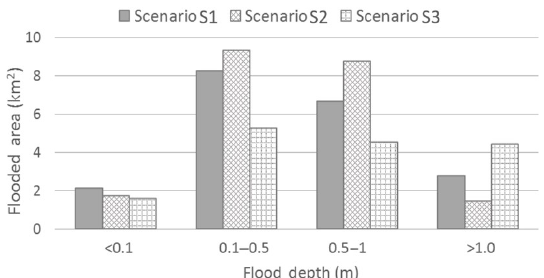
Figure 10. Flooded areas for different ranges of flood depths corre- sponding to different scenarios.